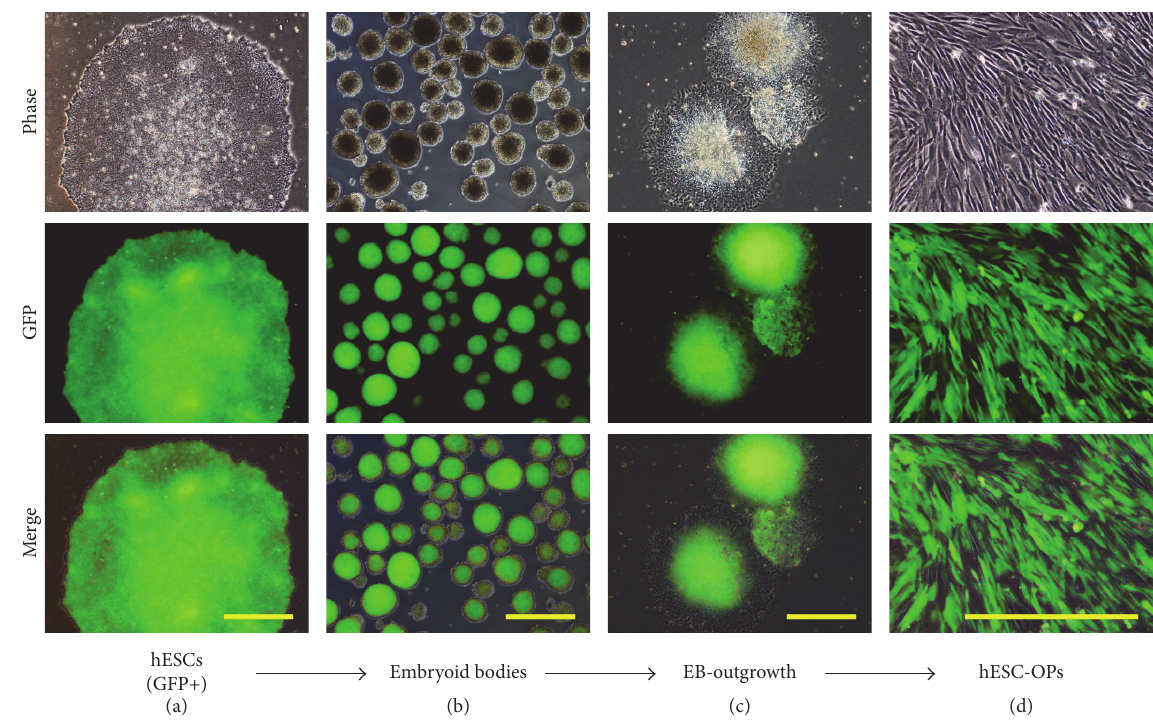
Figure 1: Differentiation of GFP-expressing hESCs into hESC-OPs. The phase contrast, fluorescent, and merged photomicrographs demon- strate the differentiation of GFP-expressing hESCs (a) into embryoid bodies (b), embryoid body outgrowth, (c) and hESC-OPs (d). Scale bar: 500 𝜇